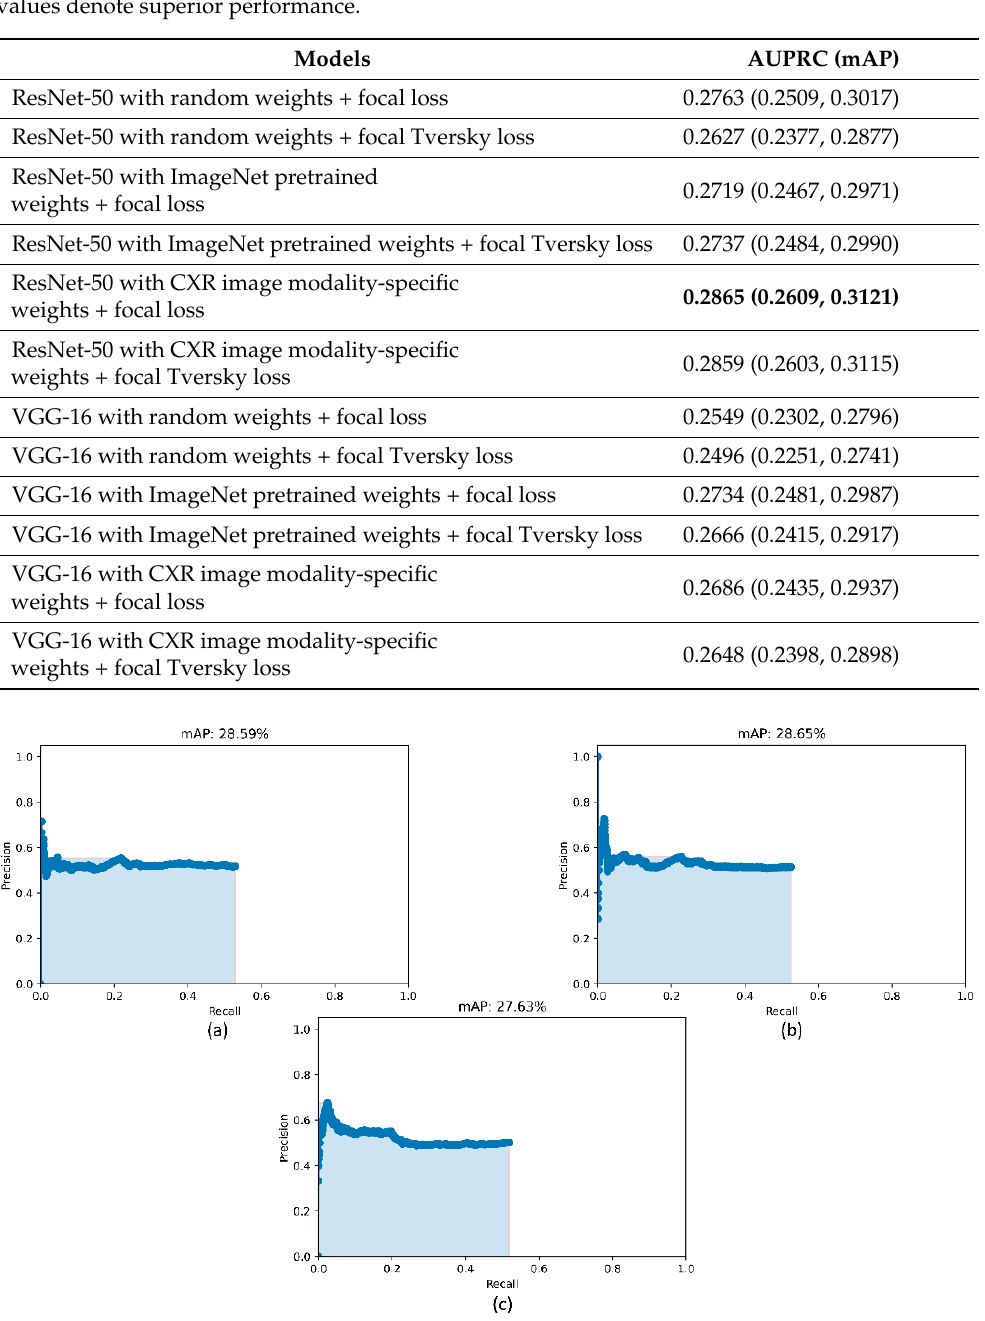
Figure 5. PR curves of the RetinaNet models initialized with varying weights for the classifier backbones. ( a ) ResNet-50 with CXR image modality-specific weights + focal Tversky loss; ( b ) ResNet-50 with CXR image modality-specific weights + focal loss, and ( c ) ResNet-50 with random weights + focal loss.